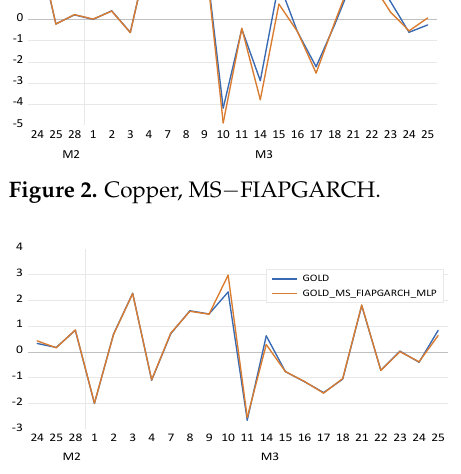
Figure 3. Gold, MS − FIAPGARCH − MLP. Figure 3. Gold, MS−FIAPGARCH−MLP. Figure 3. Gold, MS−FIAPGARCH−MLP. Figure 3. Gold, MS−FIAPGARCH−MLP.